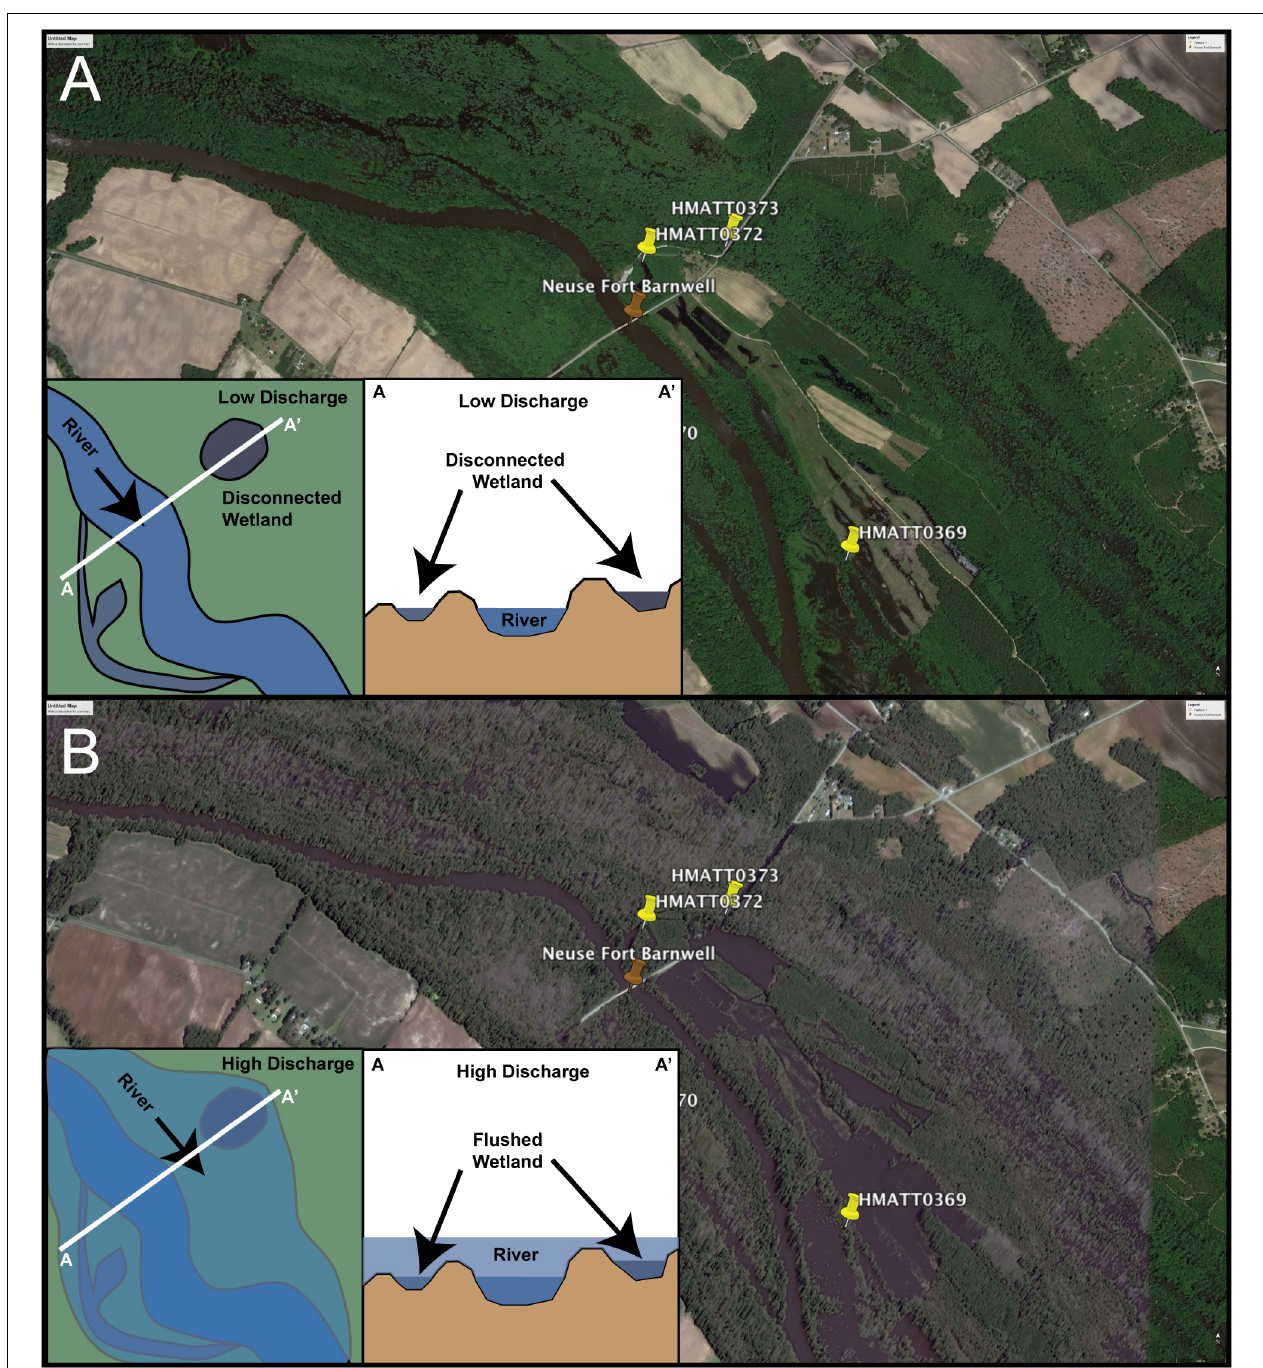
FIGURE 3 | Conceptual diagram and Google Earth Imagery of flow conditions along the Neuse River riparian wetlands during (A) low discharge (base flow) and (B) high discharge (flood stage). Insets show conceptual model of (A) disconnected and (B) hydrologically connected wetlands. Map view is depicted in the left inset, while the right inset shows the cross-section line (A–A’) . Image Data Source: 2019 Google, Maxar Technologies.